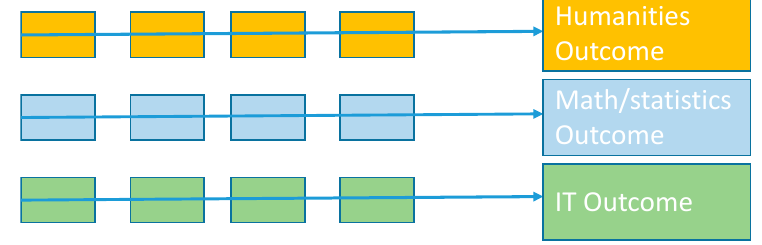
Figure 4. Traditional disciplinary content delivery.